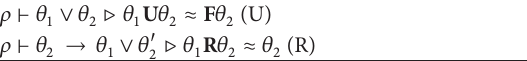
Table 6: Reduction rules of (U) and (R).